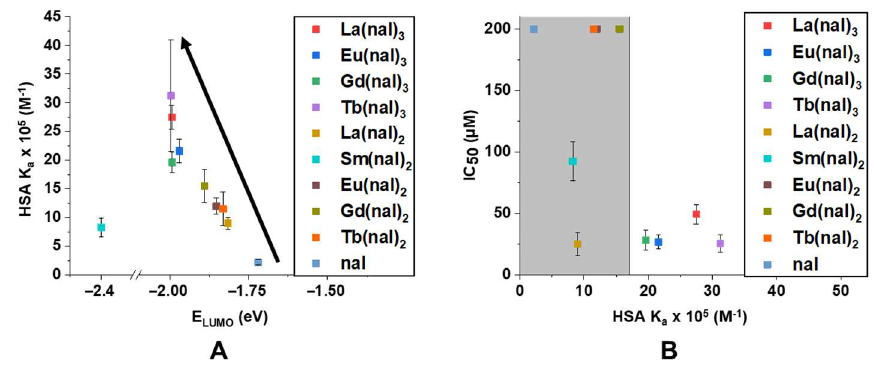
Figure 9. Graphical representations of ( A ) HSA K a × 10 5 (M − 1 ) vs. E LUMO (eV); the black arrow indicates that generally lower LUMO energy values translate to higher HSA binding affinities (note that Sm(nal) 2 and Gd(nal) 3 represent the exceptions) and ( B ) IC 50 ( µ M) vs. HSA K a × 10 5 (M − 1 ); IC 50 values were calculated for the LoVo cell line, and results > 200 µ M were attributed the value 200 on the graph; grey area shows compounds with low activity (note that La(nal) 2 represents the exception).